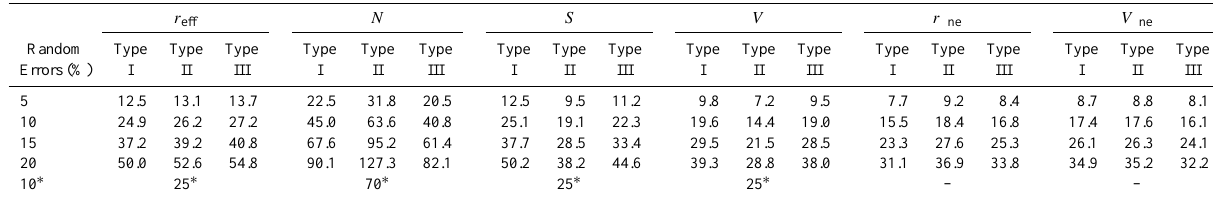
Table 2. Standard deviations of the frequency distributions of the deviation induced in the microphysical parameters due to random errors in the optical data.